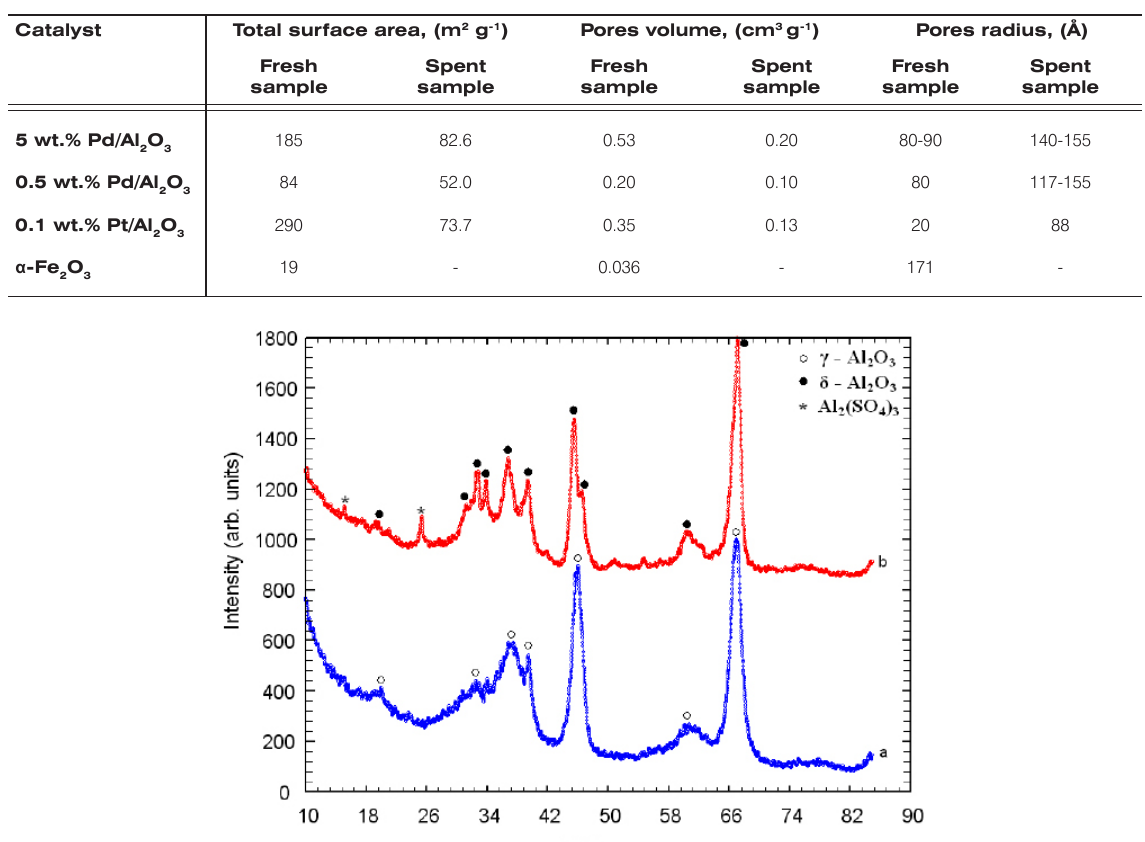
O catalyst: a - fresh sample; b - spent 2 3